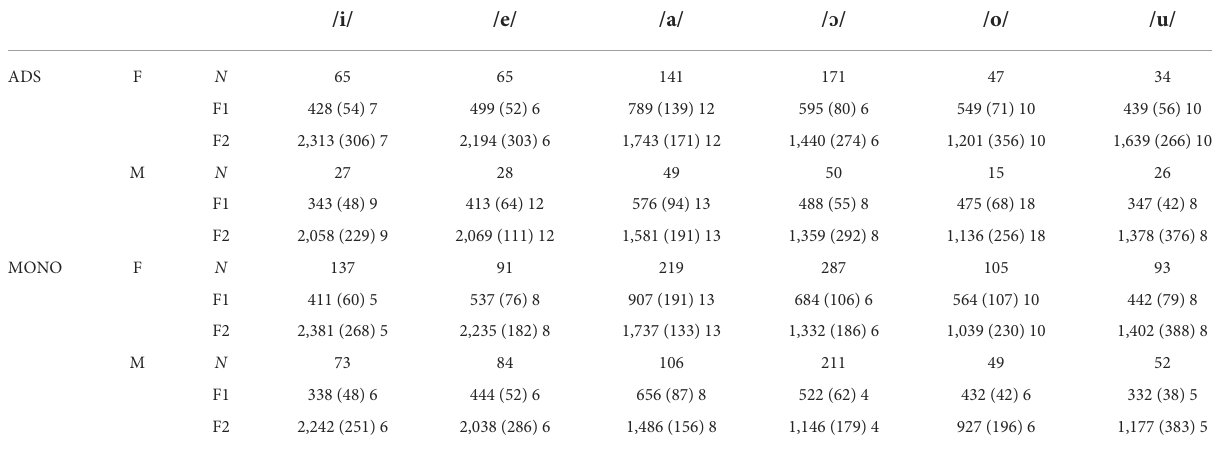
TABLE 6 Vowel token data for Nungon ADS and MONO.